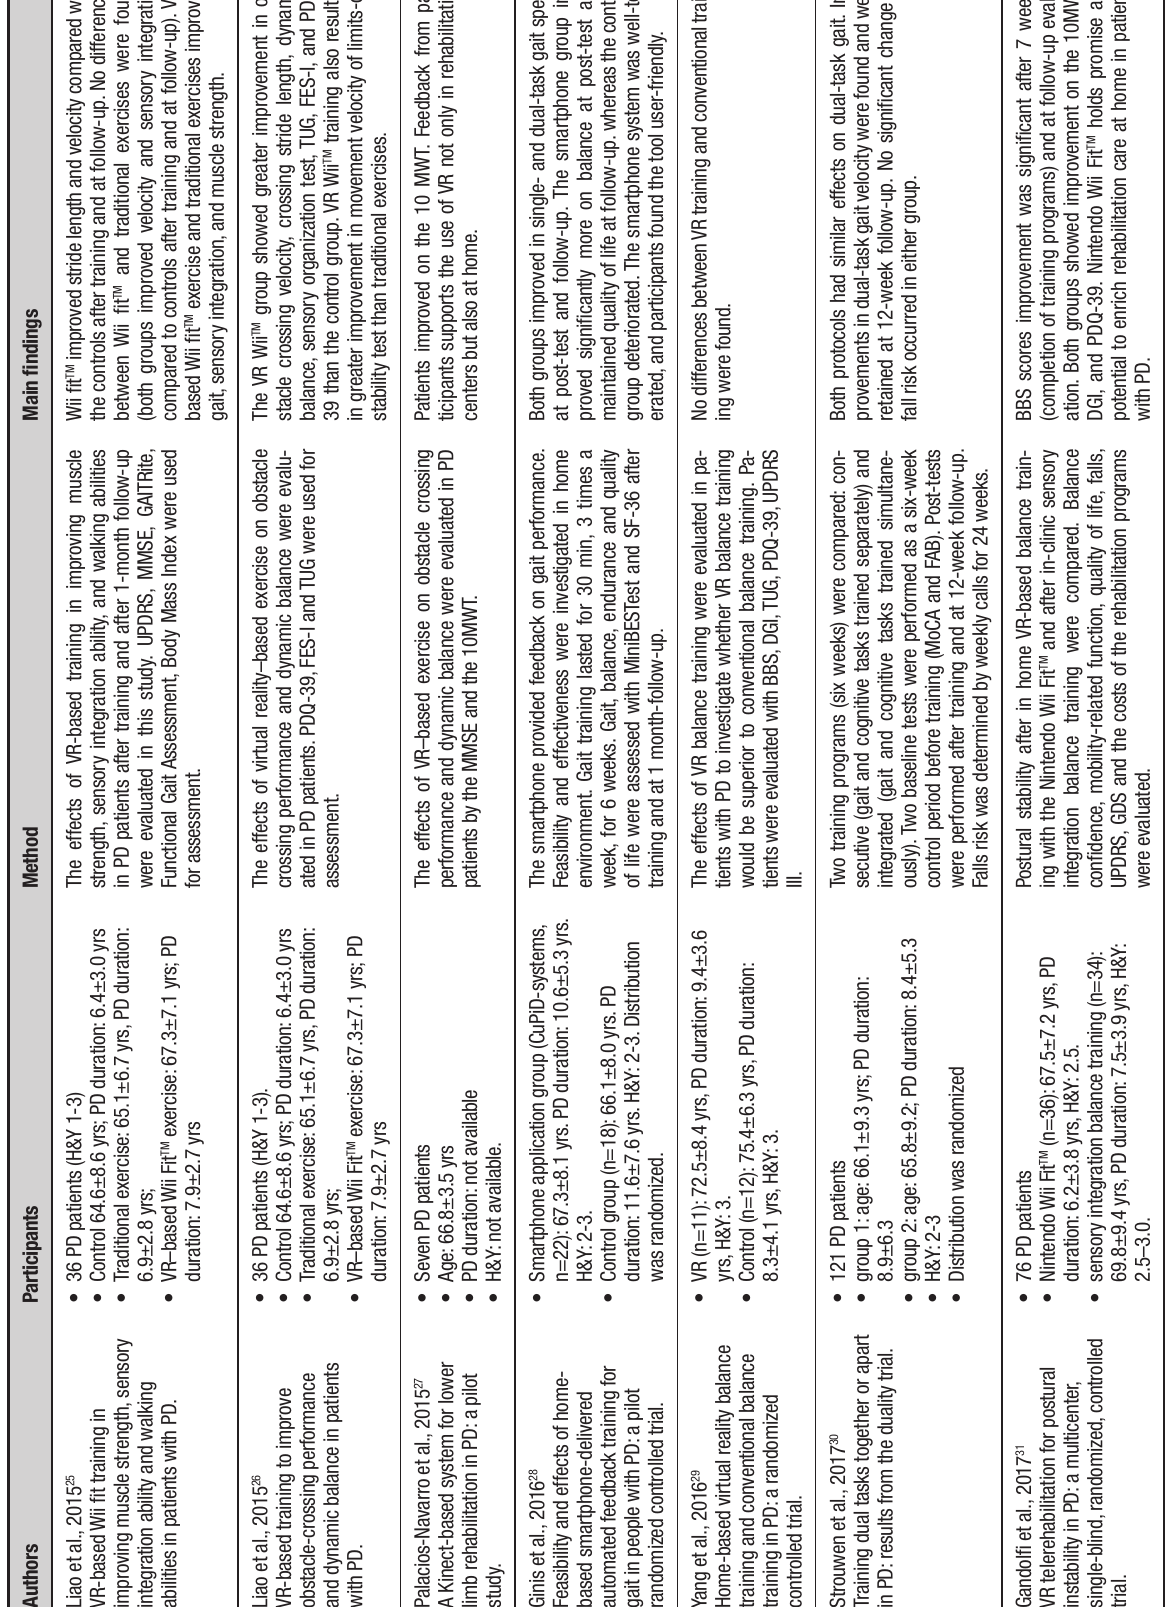
263 Freitag et al. Visual reality and gait in Parkinson’s